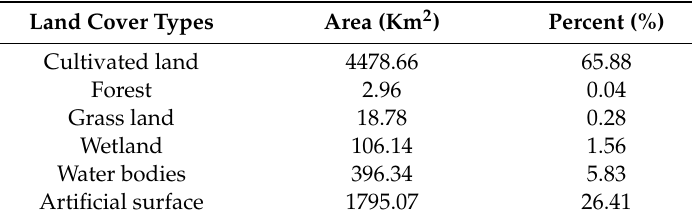
Table 1. Land cover statistical results from GlobeLand30 2000 in